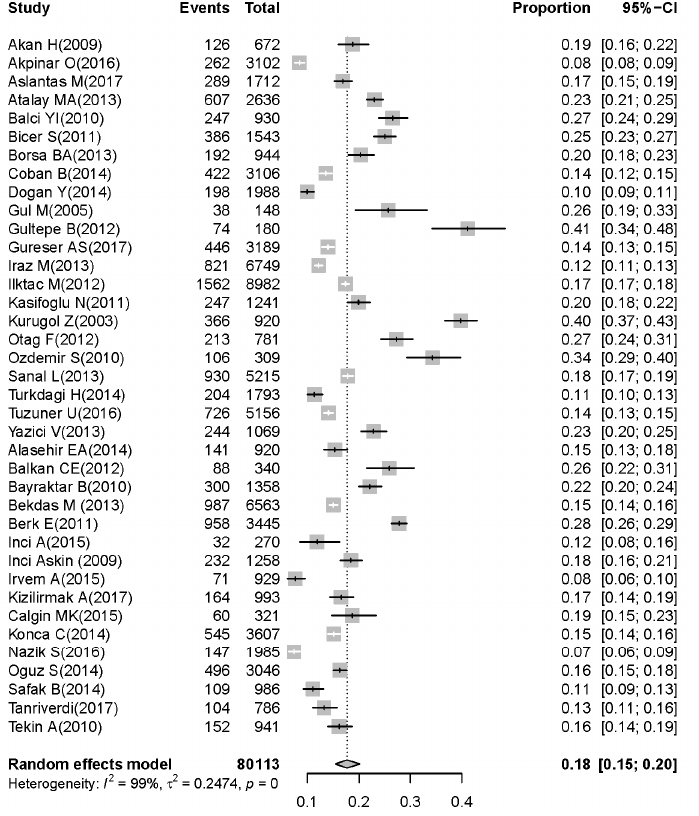
Figure 2. Prevalence of rotavirus-associated acute gastroenteritis cases in early childhood (0–5 years; results of meta-analysis for pooled prevalence with 95% confidence interval and its forest plot).